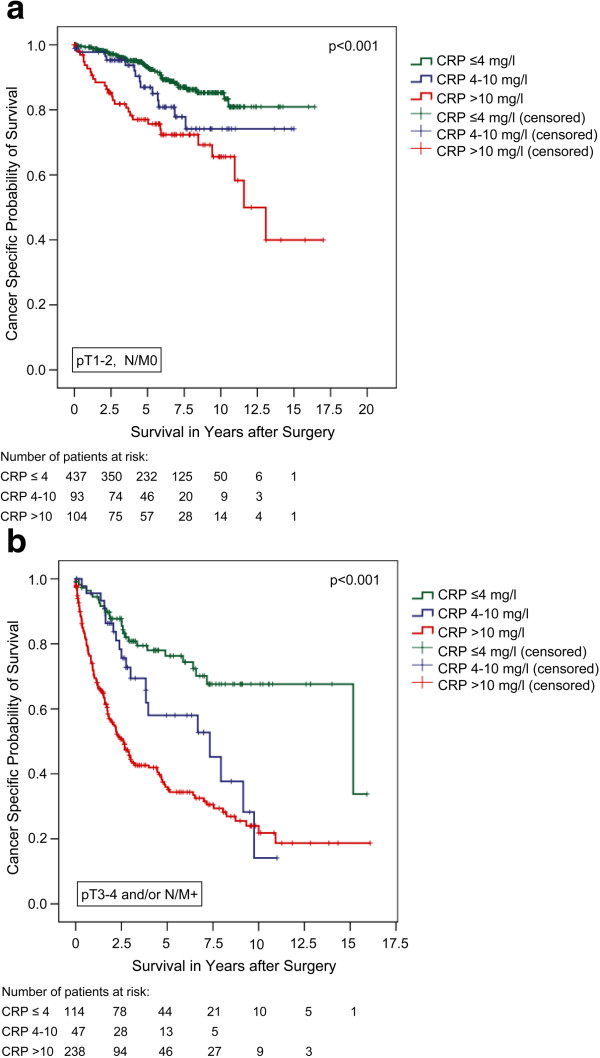
a) Cancer-specific survival (Kaplan-Meier) for organ-confined RCC plotted against the pre-operative CRP-group: The 5-year survival rate was 93.2%, 86.9%, and 77.0% for all evaluable patients (n = 634) with a CRP of ≤4 mg/l (n = 437), 4–10 mg/l (n = 93), and >10 mg/l (n = 104), respectively (p < 0.001, log rank). b) Cancer-specific survival (Kaplan-Meier) for advanced RCC plotted against the pre-operative CRP-group: The 5-year survival rate was 76.3%, 58.0%, and 35.9% for all evaluable patients (n = 399) with a CRP of ≤4 mg/l (n = 114), 4–10 mg/l (n = 47), and >10 mg/l (n = 238), respectively (p < 0.001, log rank).